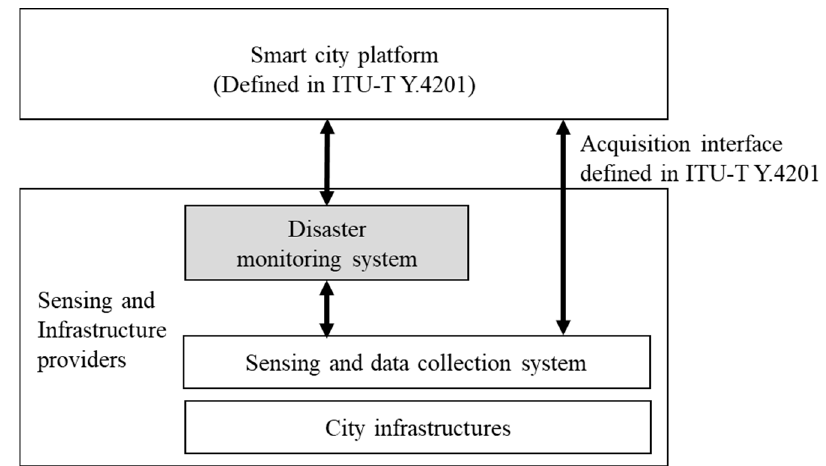
Figure 5. Interoperability of SCP, DMS, and city infrastructure.